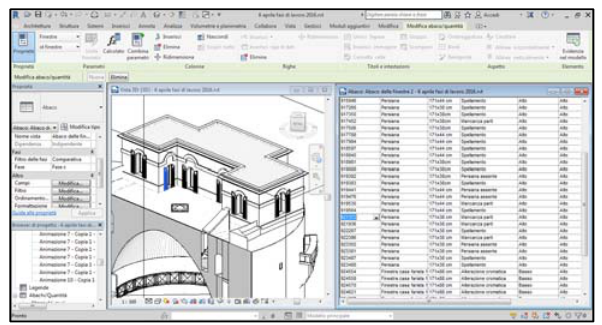
Figure 5. Objects, data and information in